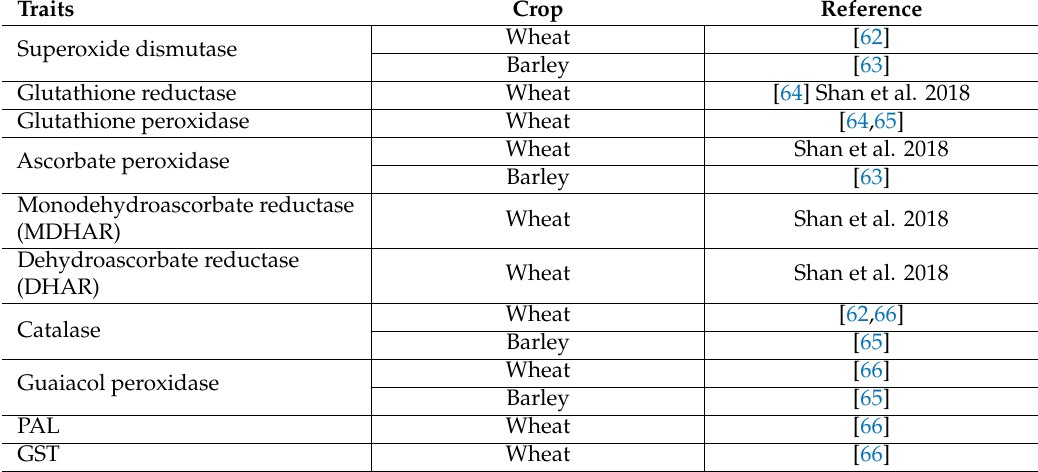
Table 1. List of important enzymatic activities that are increased and activated in wheat and barley under drought